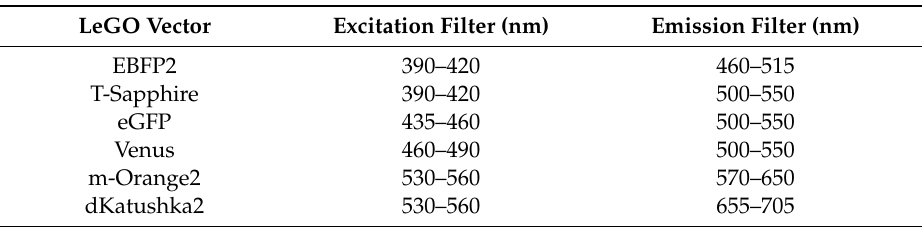
Table 4. Operetta CLS configuration.